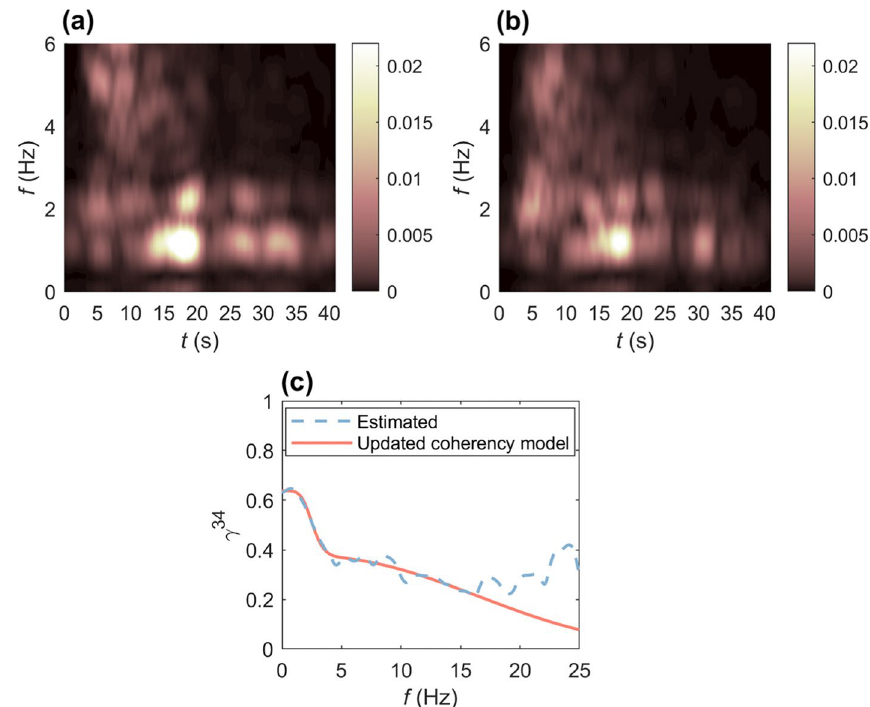
Fig. 11 Spectra and coherence analysis based on the measured earthquake data in the Jiuzhou bridge case: a the estimated EPSD at site 3, b the estimated EPSD at site 4, and c the estimated coherence between sites 3-4 and the updated coherency model